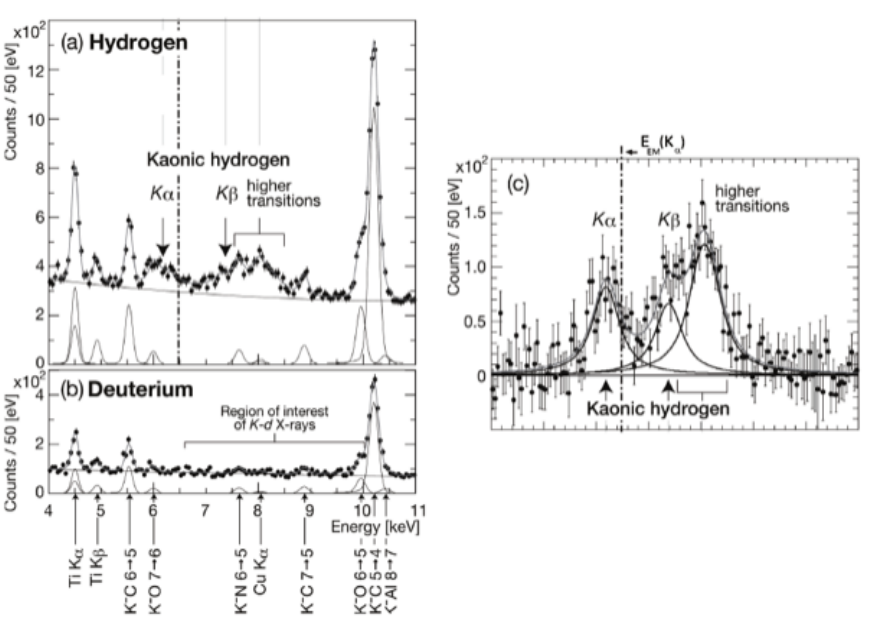
Figure 6: The simultaneous fit of the X-ray energy spectra of hydrogen and deuterium data. ( a ), ( b ) Measured energy spectra with fitted lines. Fit components of the back- ground (X-ray lines and a continuous background) are marked with solid lines. The dot-dashed vertical line indicates the electromagnetic value of the kaonic hydrogen K α energy. ( c ) The measured kaonic hydrogen X-ray spectrum after background sub- traction. The fit components corresponding to the K − p transitions are shown [ 7 ] . Adapted from [ 1 ]